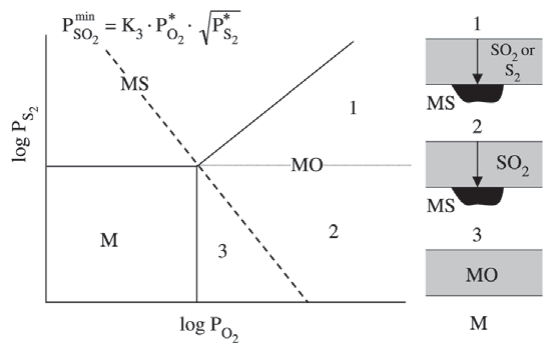
Figure 3. Application of the phase-stability diagram in identify- ing possible modes of attack. In this schematic diagram, the slope for is